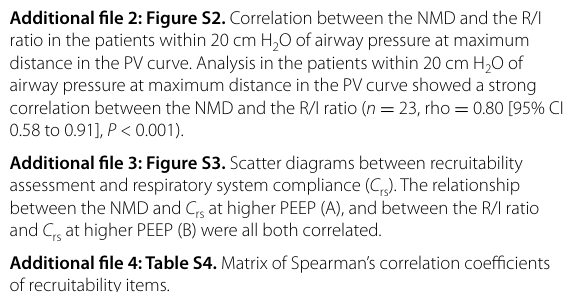
Additional file 2: Figure S2. Correlation between the NMD and the R/I ratio in the patients within 20 cm H 2 O of airway pressure at maximum distance in the PV curve. Analysis in the patients within 20 cm H 2 O of airway pressure at maximum distance in the PV curve showed a strong correlation between the NMD and the R/I ratio ( n 0.58 to 0.91], P < 0.001). Additional file 3: Figure S3. Scatter diagrams between recruitability assessment and respiratory system compliance ( C rs ). The relationship between the NMD and C rs at higher PEEP (A), and between the R/I ratio and C rs at higher PEEP (B) were all both correlated. Additional file 4: Table S4. Matrix of Spearman’s correlation coefficients of recruitability